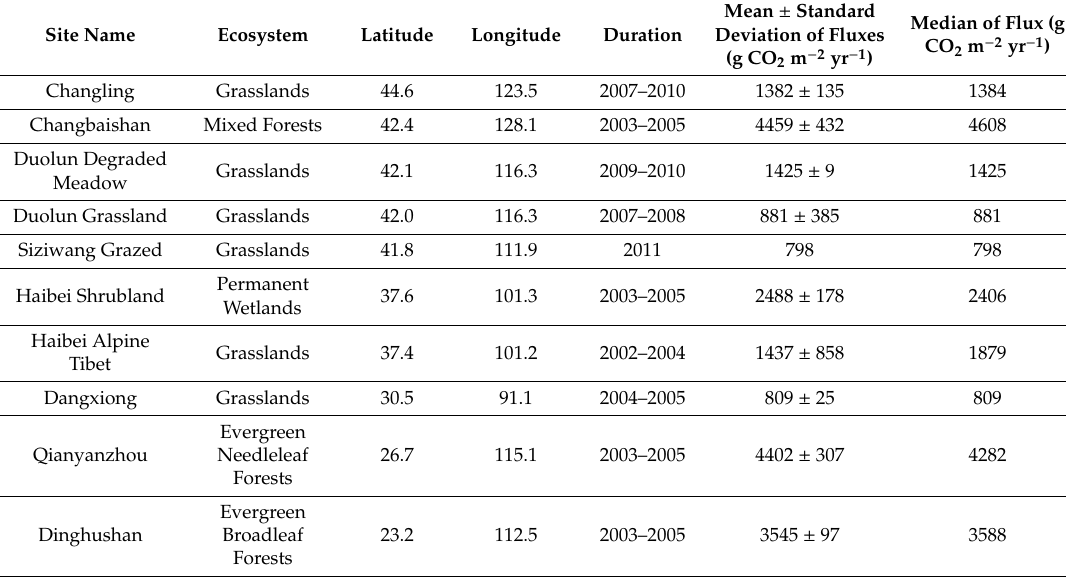
Table 2. Basic information on the 10 flux observation sites using eddy covariance technique.